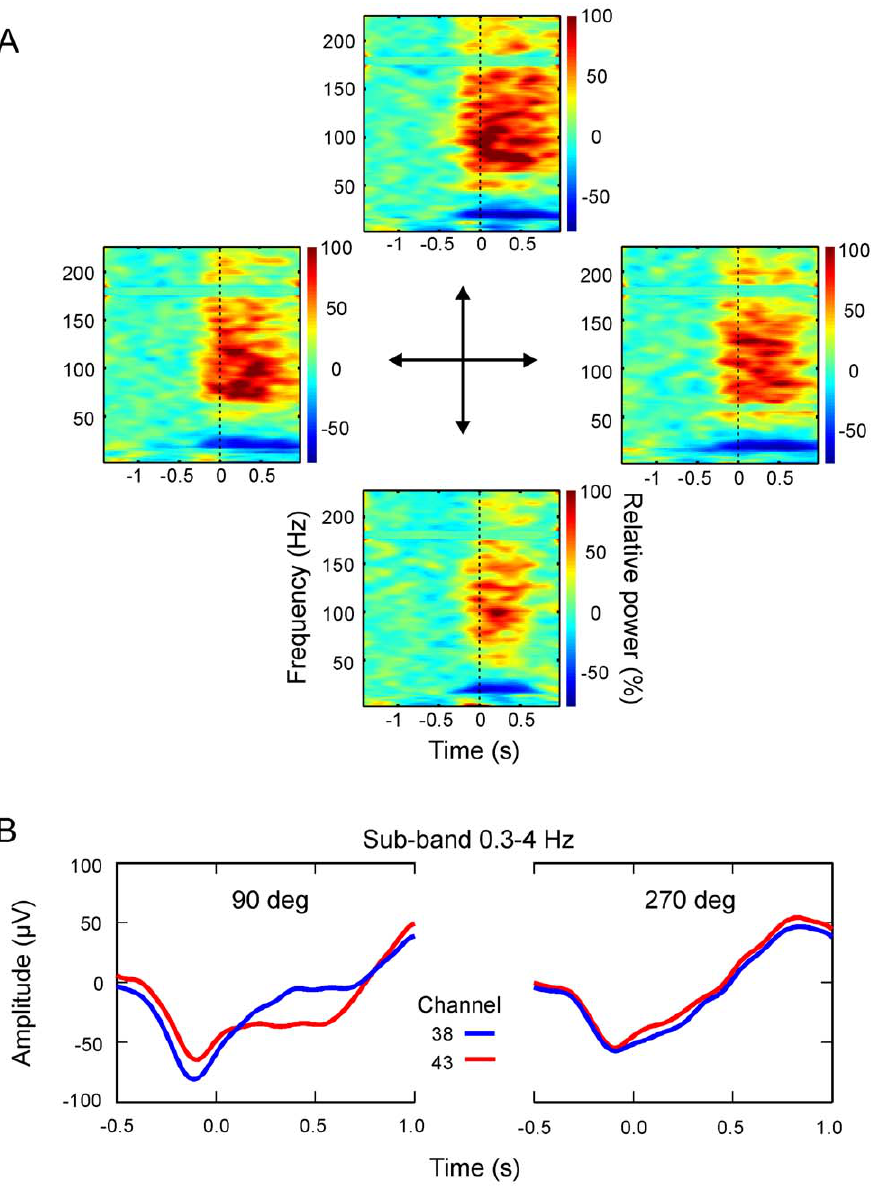
Figure 2. Modulation of LFP across target direction. (A) Time-frequency maps of LFP signals from one channel in M1 for 4 target directions (out of 8) during the instructed-delay center-out task. The data were aligned to the onset of movement (t=0 s). The color map represents the change in power relative to baseline. The central arrows indicate the target direction associated with the different maps. The most reactive frequency bands were selected from these time-frequency maps for decomposing the LFP data into sub-bands. (B) Average LFP data in the 0.3–4 Hz band of two representative channels for the 90 deg and 270 deg target directions. The data were aligned to the onset of movement (t=0 s). Note the difference in correlation between channels for these two directions. This characteristic was used for target direction decoding on a single trial